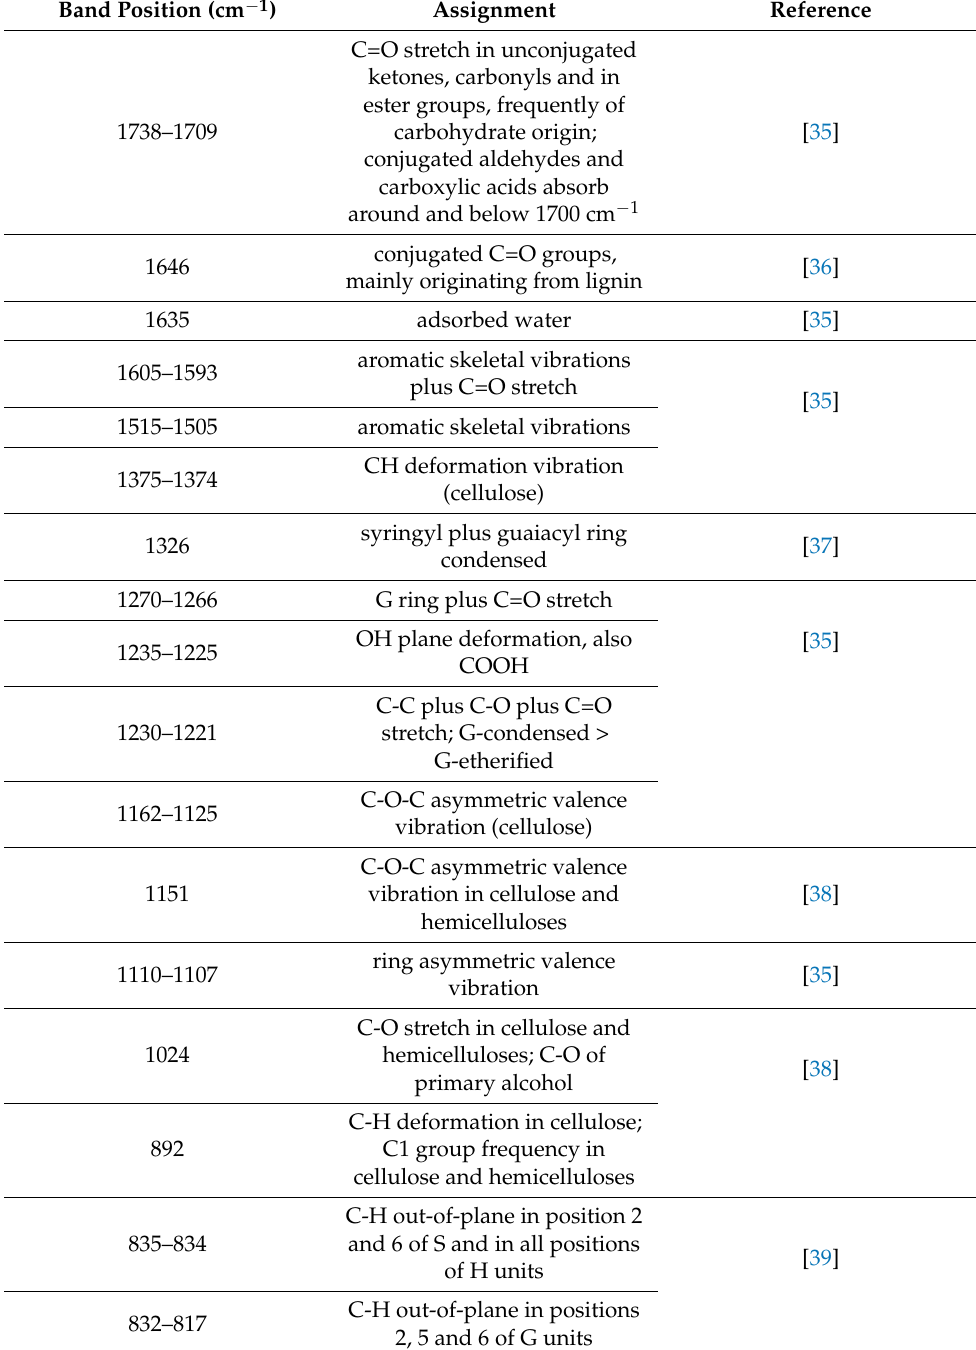
Table 5. Overview of band assignments for infrared